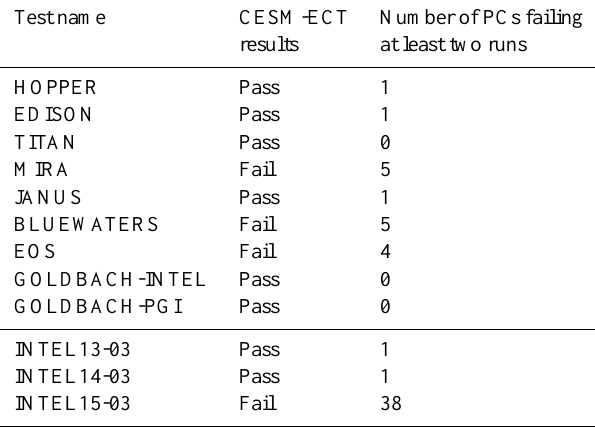
Table 3. CESM modifications with unknown